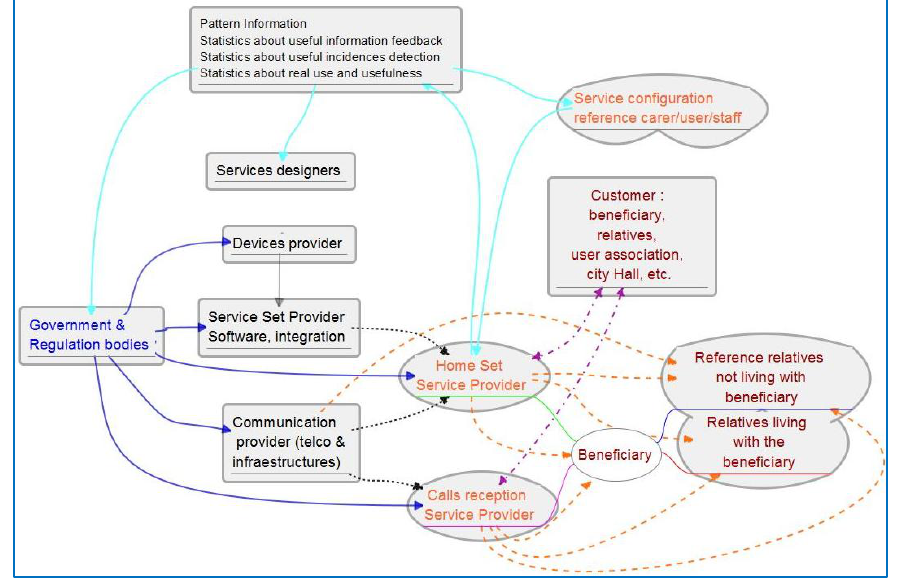
Figure 12. Service provision chain and pattern use for reconfiguration, redesign and regulation bodies